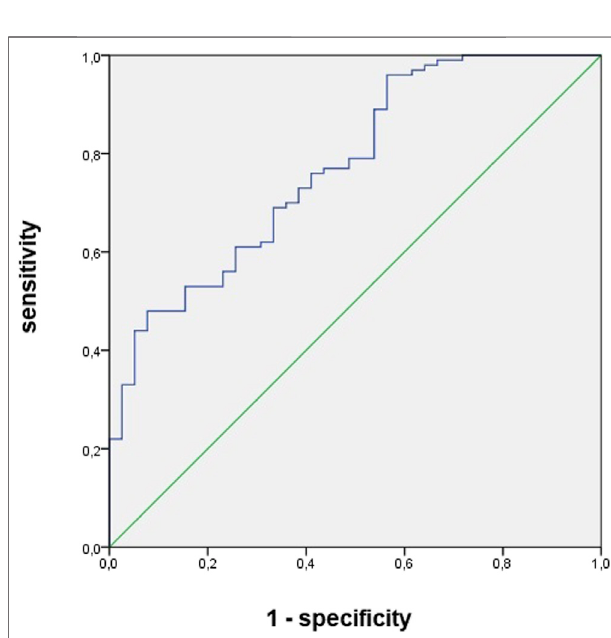
FIGURE 3 | Area under curve of urinary NGAL between 144 and 192 h as predictors of acute kidney injury diagnosis in patients undergoing vancomycin and hospitalized in wards.